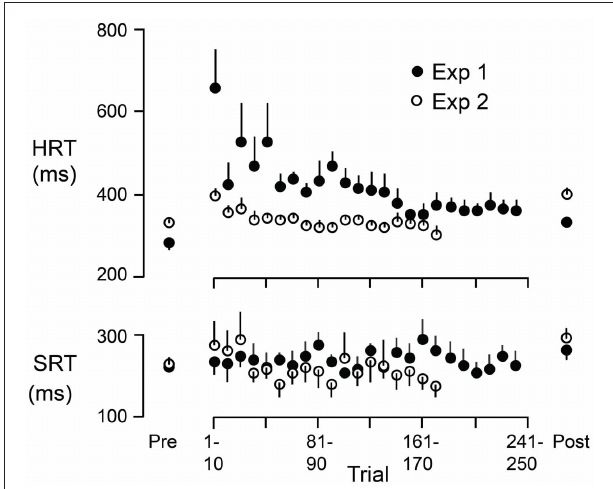
FIGURE 6 | HRT and SRT as a function of trial during the adaptation periods of Experiment 1 (filled circles) and Experiment 2 (open circles). Each point represents the mean across participants where the reaction time for each participant is the average across 10 successive trials. The figure also shows, for each experiment, HRT and SRT for eye + hand trials during the pre-adaptation and the post-adaptation phases. Each point represents the mean across participants. The vertical lines represent